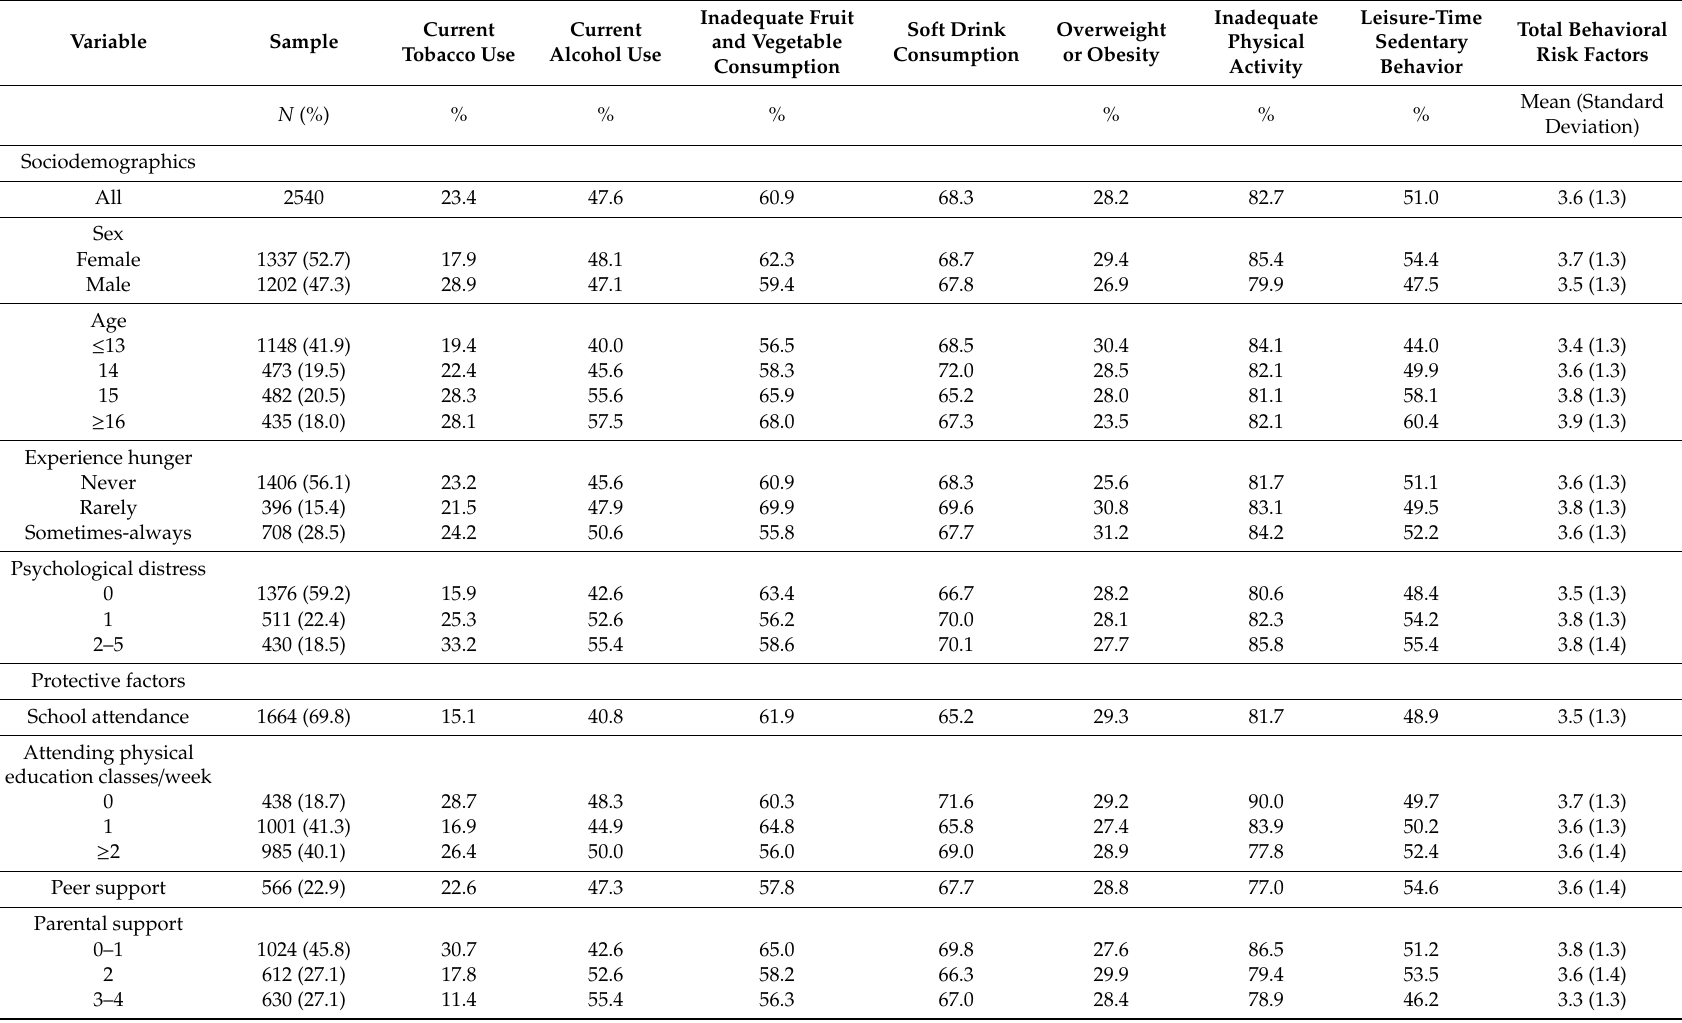
Table 1. Sample characteristics and distribution of behavioral risk factors of non-communicable diseases in